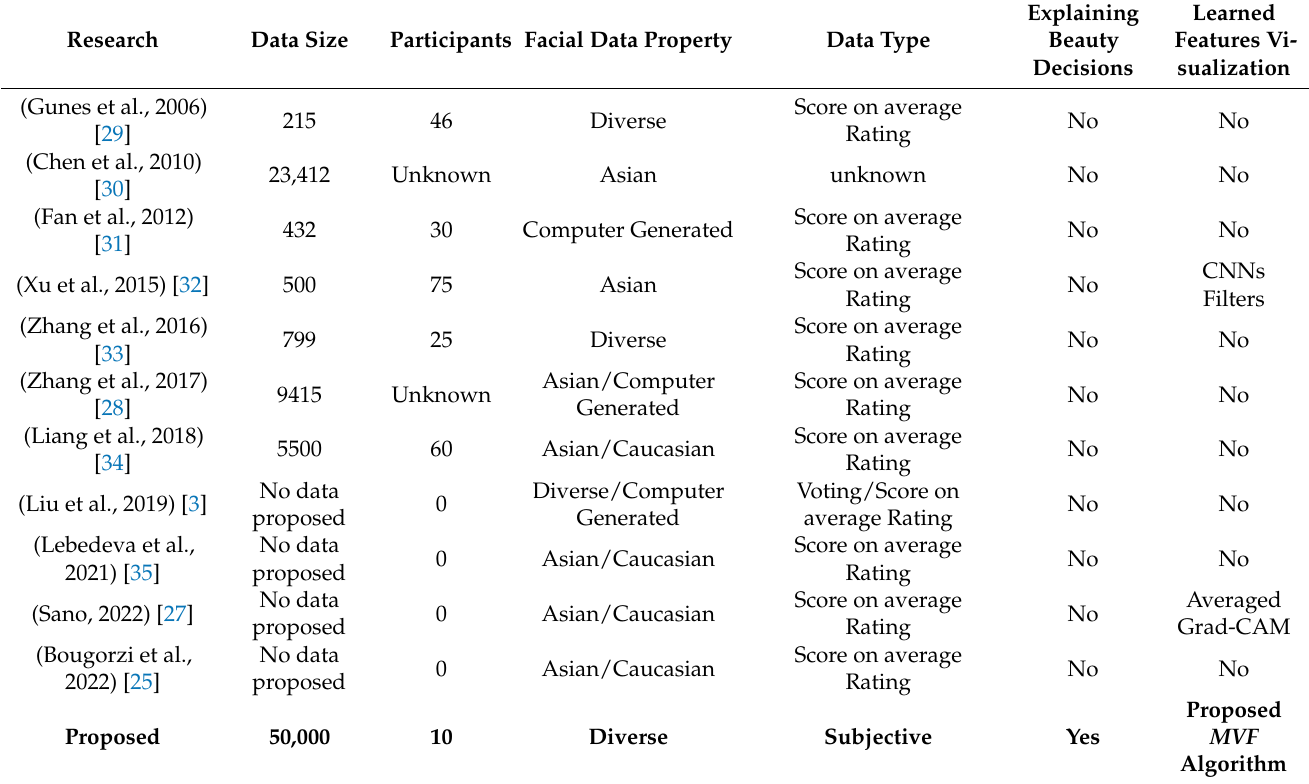
Table 1. Review of certain existing research on facial beauty